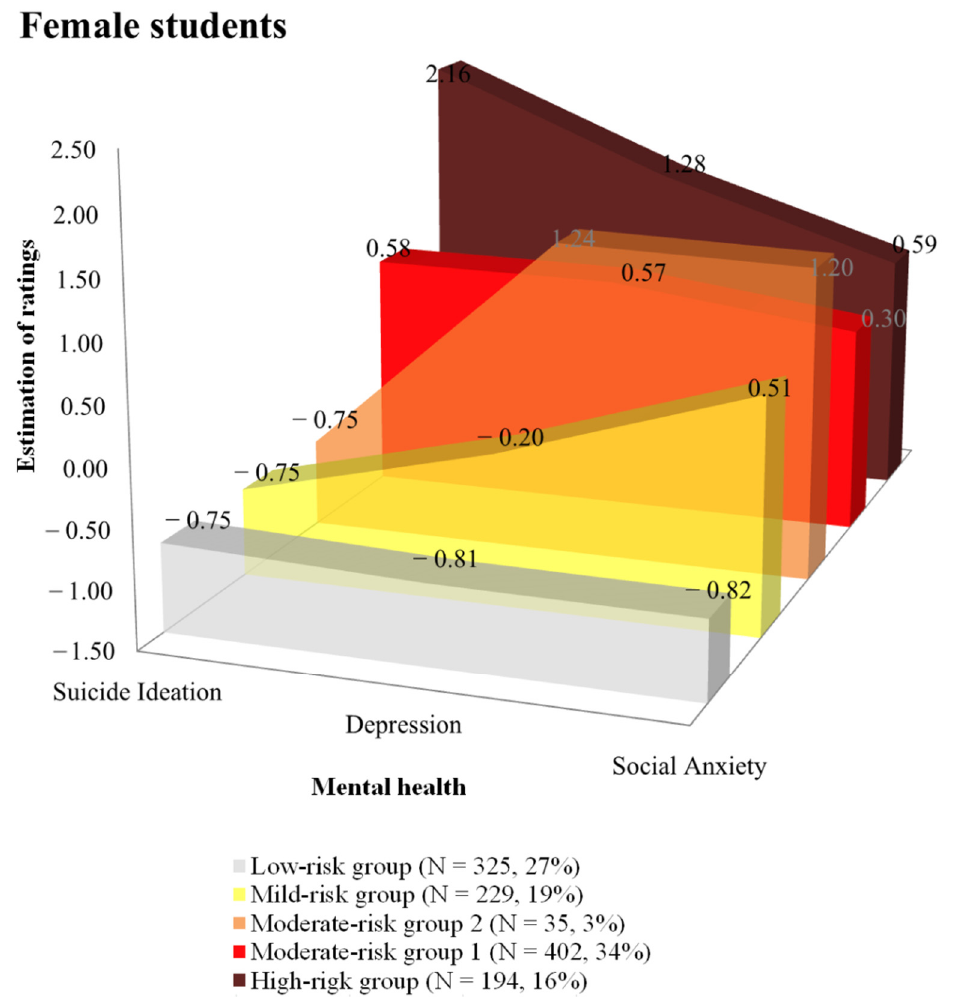
Figure 2. Five profiles in the mental health of Korean female youth.